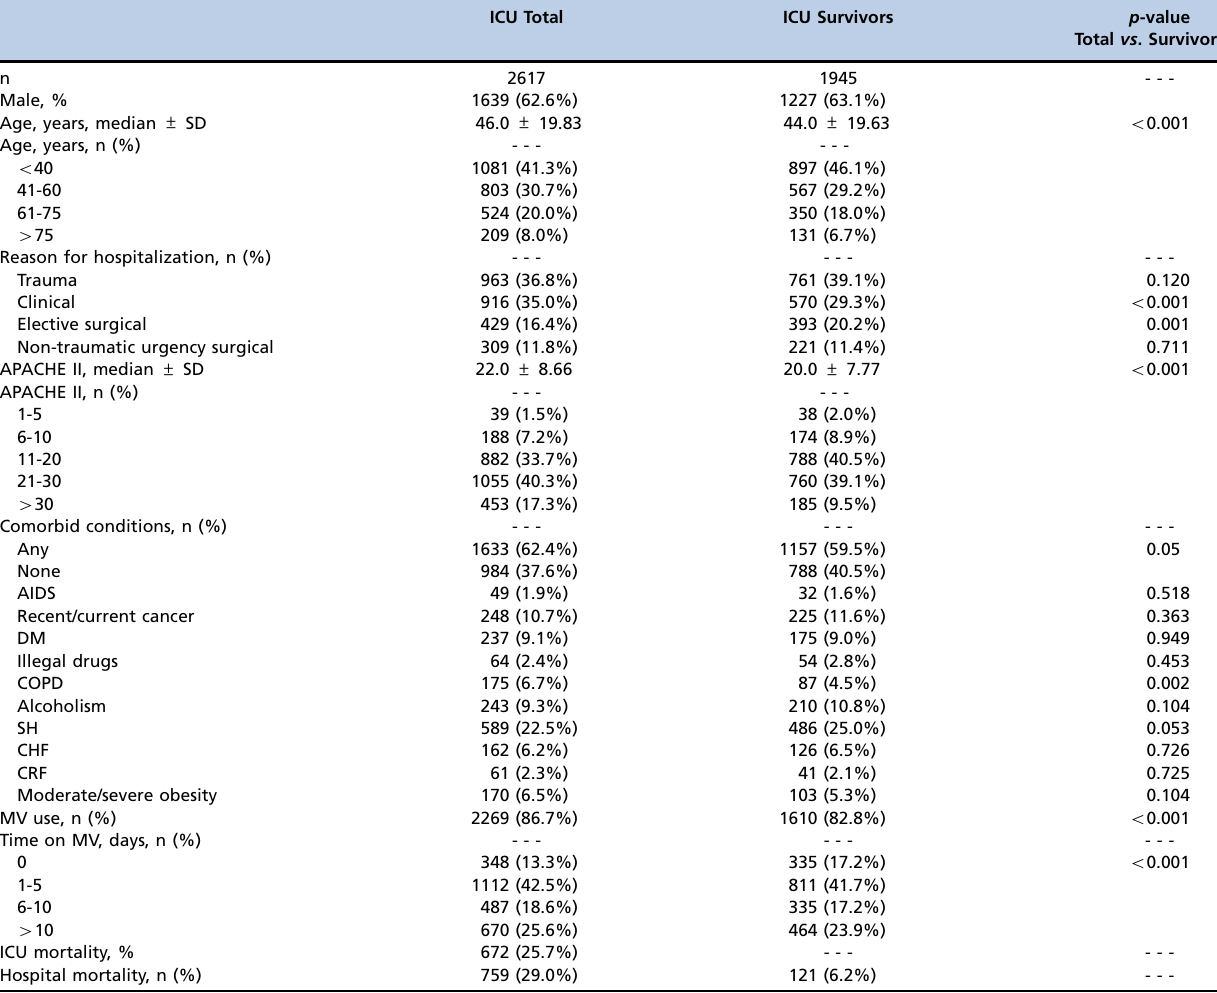
Supplementary Table - Comparison of admitted ICU patients to ICU surviving patients. ICU Total ICU Survivors p -value